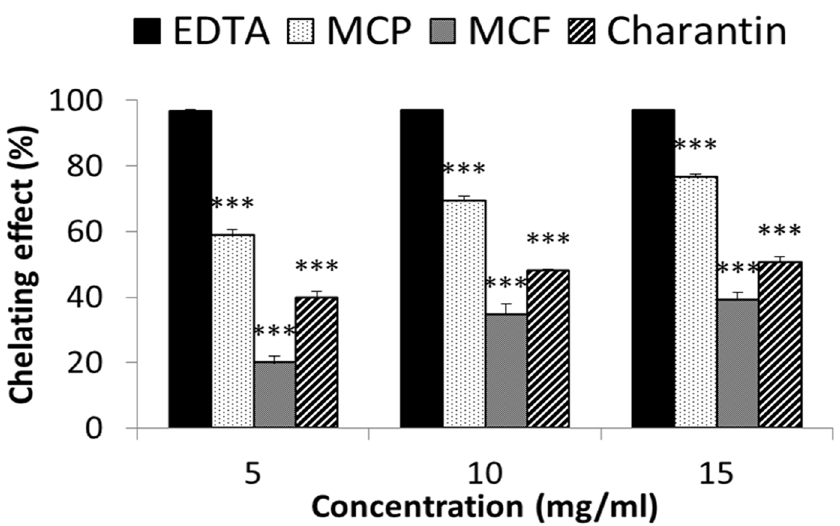
Fig 4. Metal chelating activity of different concentrations of MCP, MCF and charantin. Chelating effects of 5 – 15 mg/ml of MCP, MCF and charantin extracts were determined over a period of 10 minutes at room temperature using the ferrozine method. EDTA was used as a positive control. The results are presented as mean ± SD (n = 3). *** : p < 0.001 vs control.